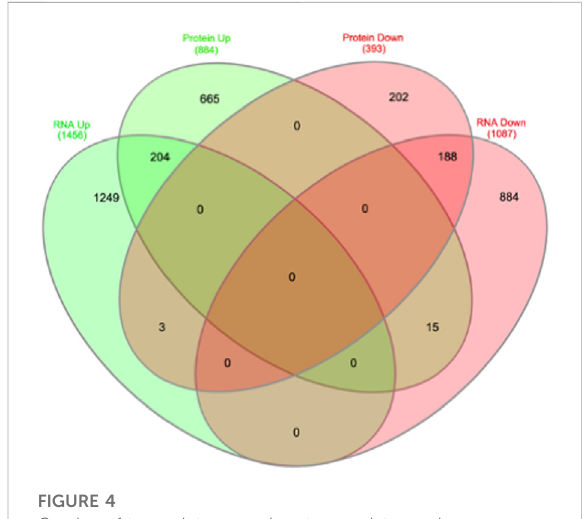
FIGURE 4 Overlap of transcriptome and proteome data overlap identi fi es 410 common targets, of which 18 are